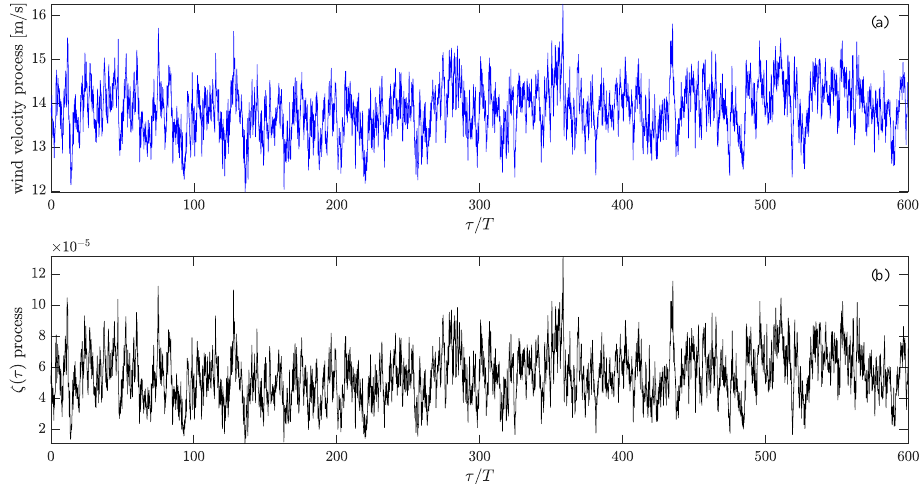
Figure 5. Wind velocity process and corresponding time dependent random forcing process ζ = Γ ω k / ( 2 g ρ w ) − 2 k 2 ν for V m = 14 m/s and σ v = 1